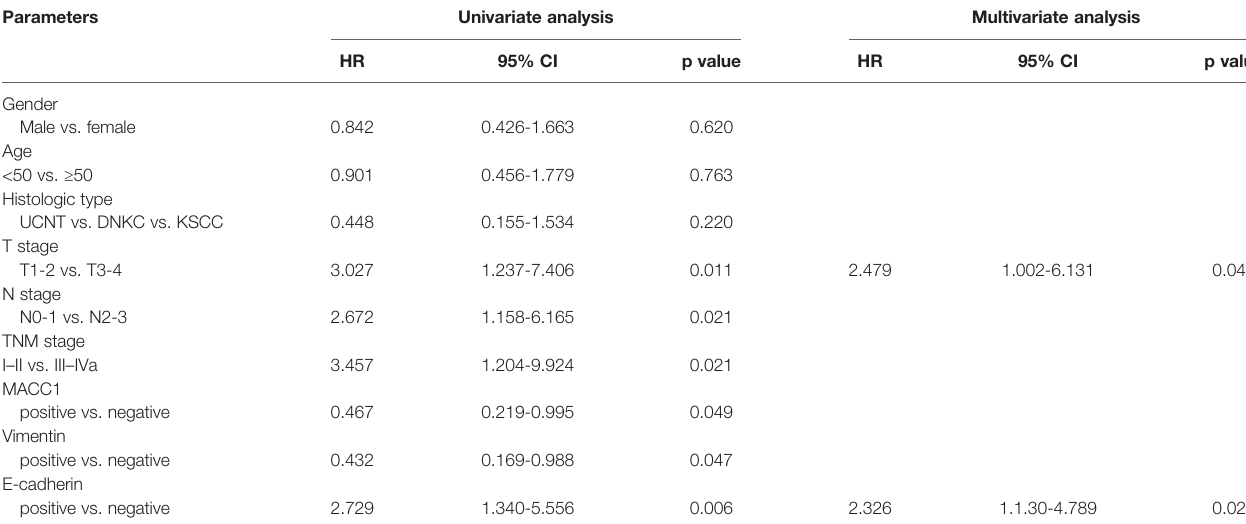
TABLE 2 | Univariate and multivariate analyses of prognostic factors for 5-year overall survival of NPC patients. Parameters Univariate analysis Multivariate analysis